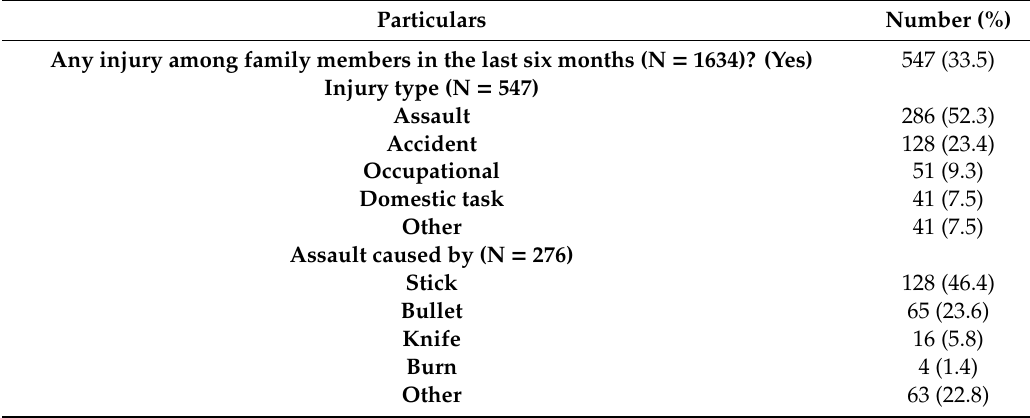
Table 5. Injuries, animal bites and deaths among Rohingya families as reported by primary respondents interviewed in Cox’s